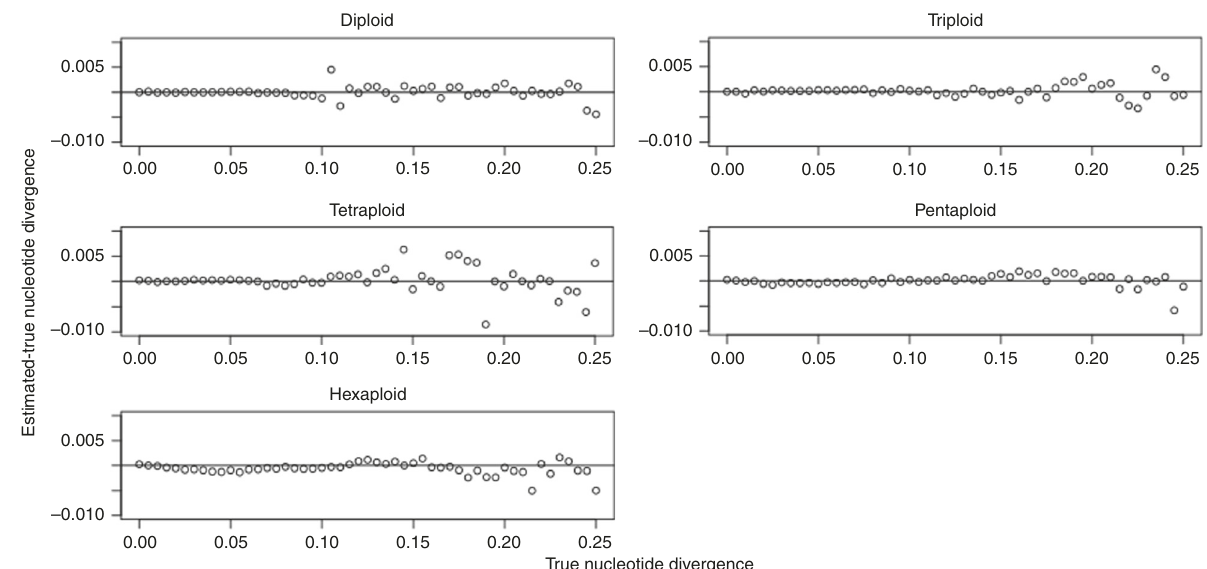
Fig. 3 Nucleotide divergence parameter sweep. Results shown for diploid, triploid, tetraploid, pentaploid, and hexaploid simulated datasets.